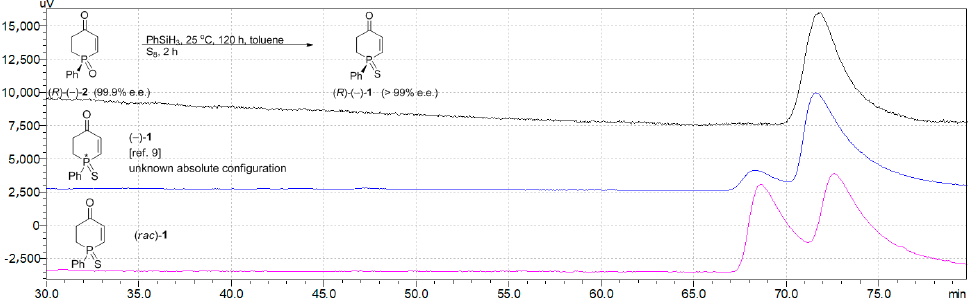
Figure 13. Assignment of the absolute configurations by chemical correlation. Copies of CSP-HPLC traces of— rac- 1 ;—( − )- 1 ;—sulfide 1 from the correlation traces of — rac- 1 ; — ( − )- 1 ; — sulfide 1 from the correlation experiment.